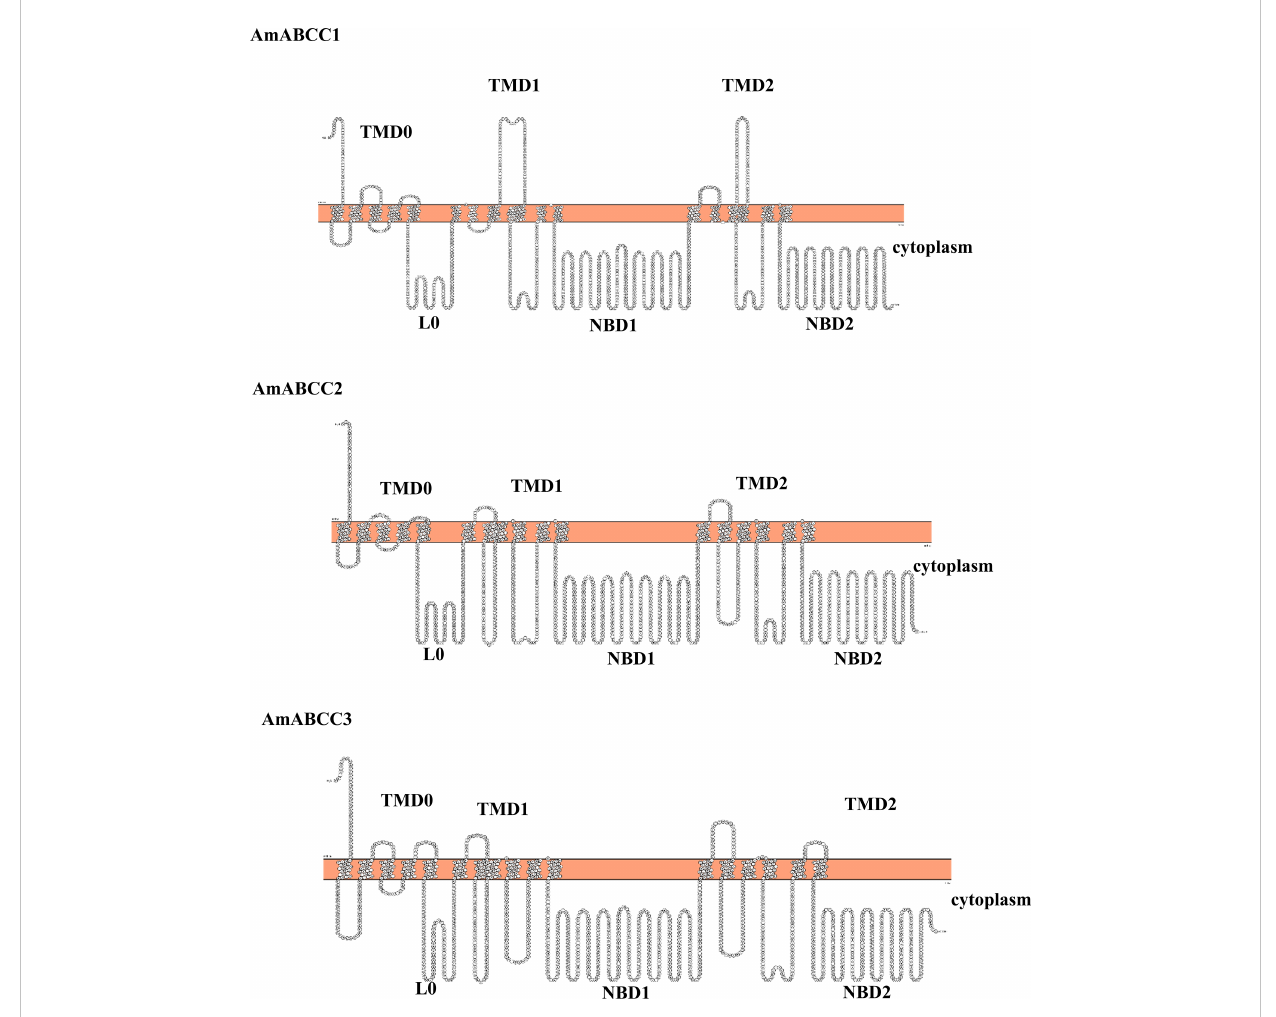
FIGURE 8 Predicted topology of Am ABC sub-family C transporters. The topology models of Am ABCC1, Am ABCC2 and Am ABCC3 membrane proteins illustrating the two cytoplasmic nucleotide-binding domains (NBDs) and the three transmembrane domains